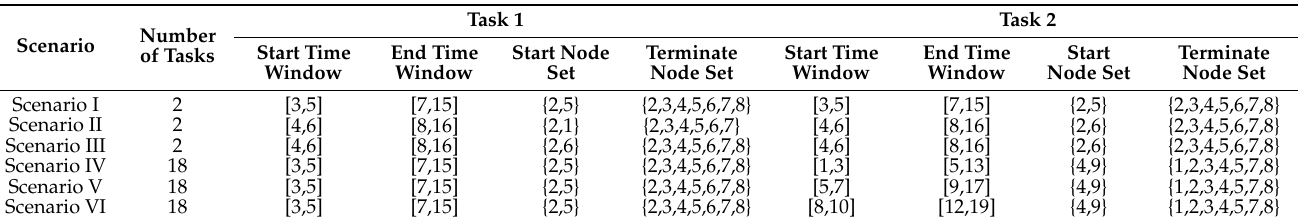
Table 8. Description of some tasks in the